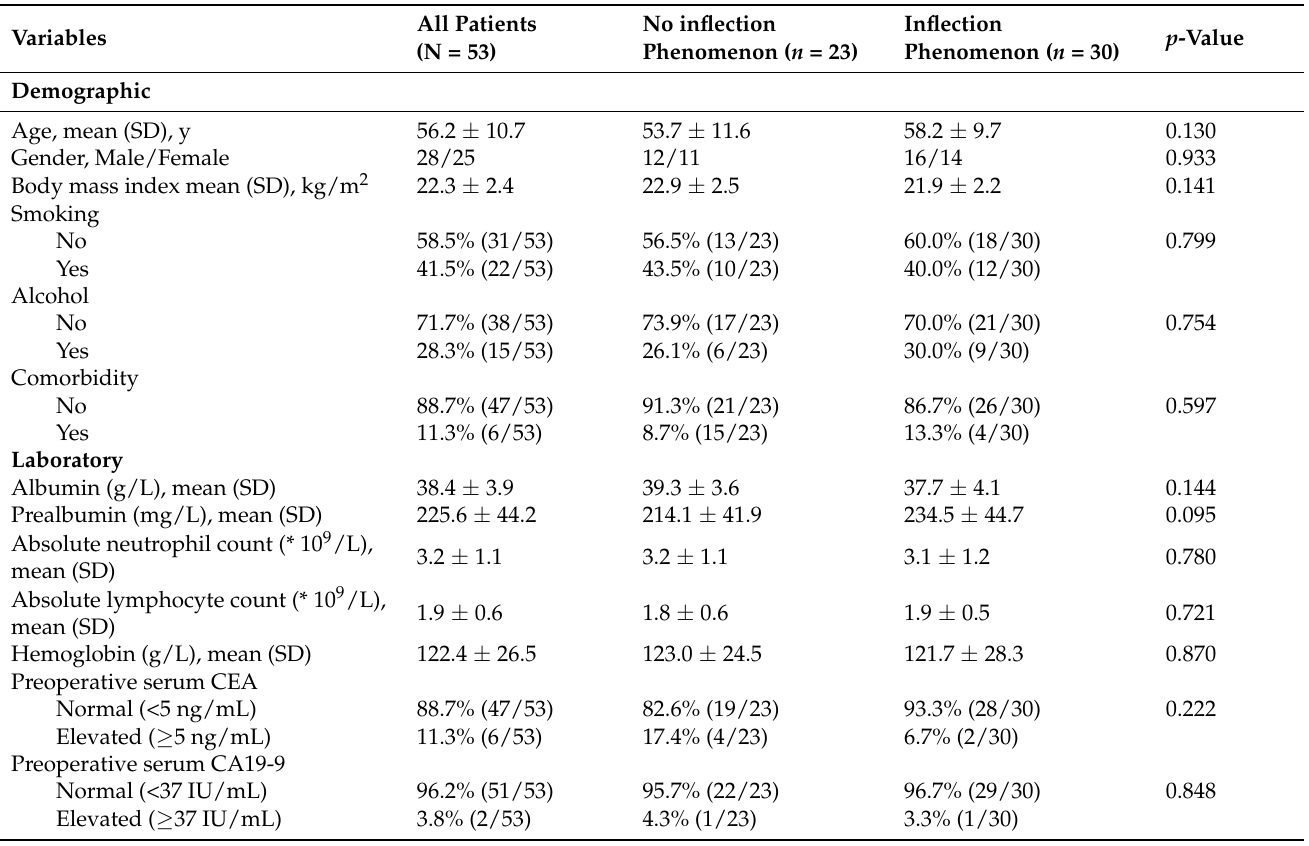
Table 1. The demographic and laboratory characteristics of all patients ( n = 53).